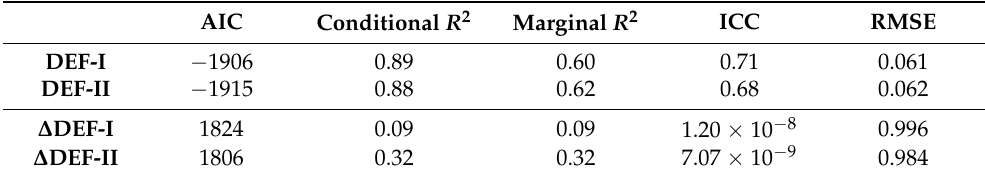
Table 2. Defoliation (DEF) and defoliation change ( ∆ DEF) model performance indices: Akaike Information Criterion (AIC); Conditional coefficient of determination (Conditional R 2 ); Marginal coefficient of determination (Marginal R 2 ); Intraclass Correlation Coefficient (ICC); Root Mean Square Error (RMSE). AIC Conditional R 2